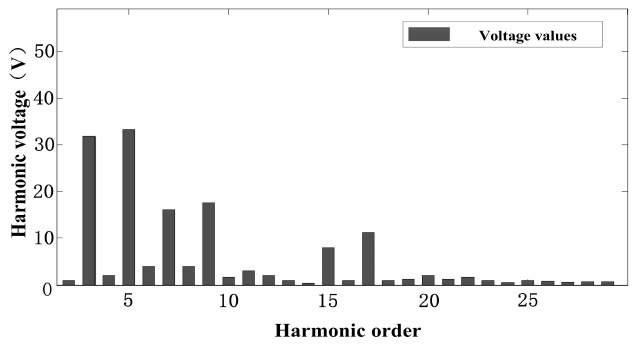
Figure 10. The low-order voltage harmonics of RSC in sub-synchronous state. The rotor current harmonics are shown in Figure 11.